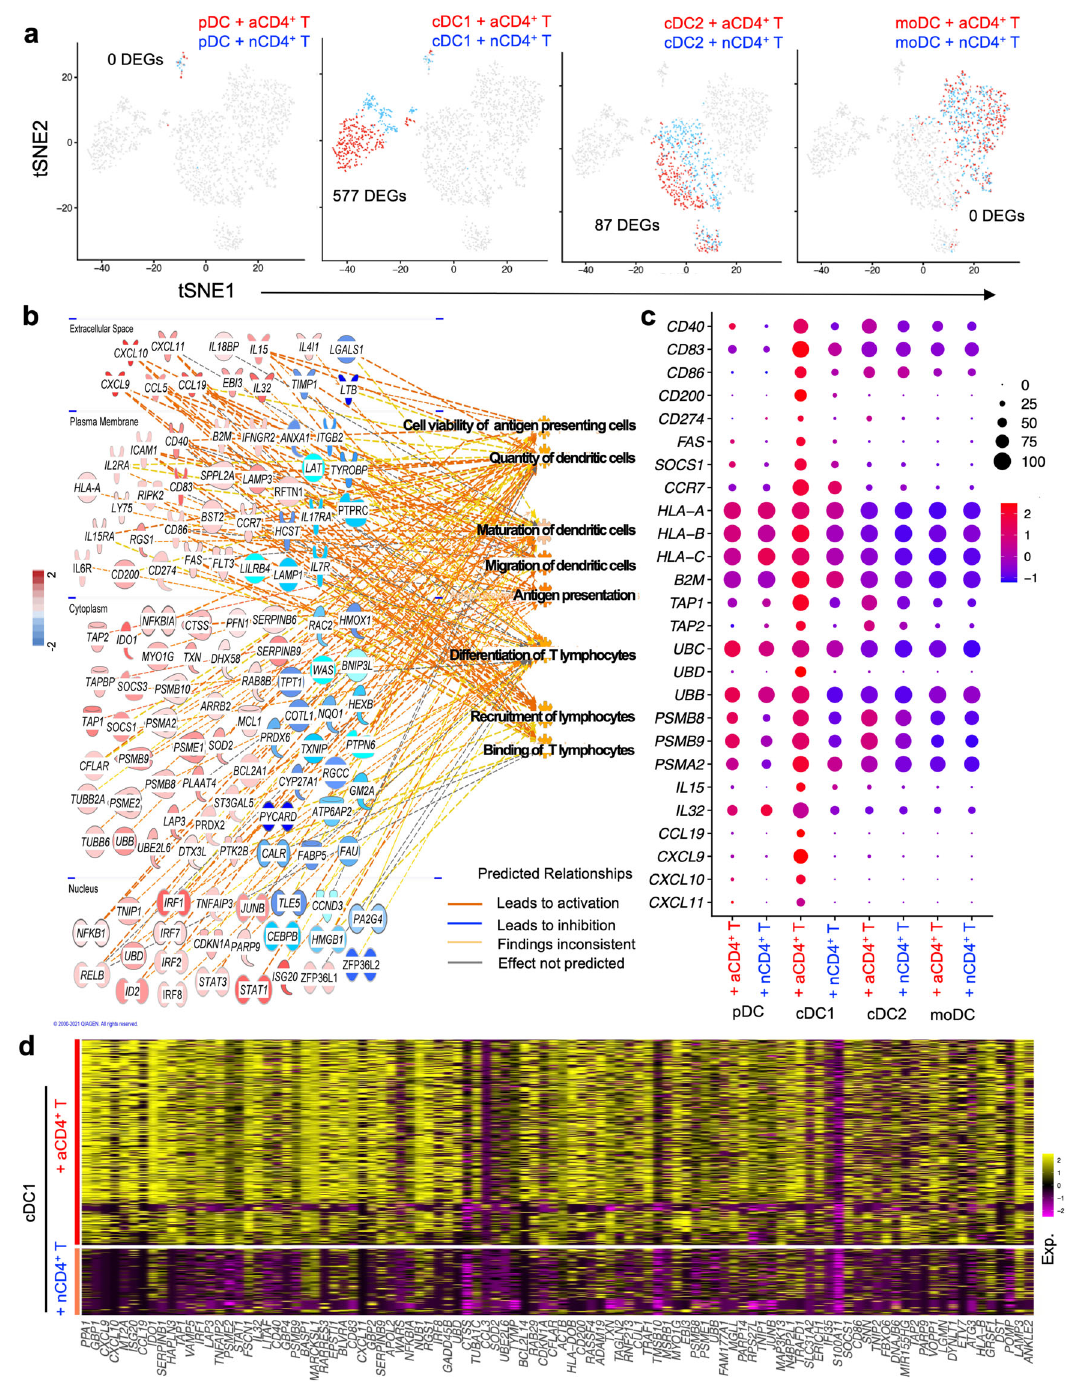
Fig. 1 | “ Helped ” cDC1 increase expressionofmolecular pathways thatsupport CTL cross-priming. CD11c − CD303 + pDC, CD11c + CD141 + cDC1, CD11c + CD1c + cDC2 andCD11c + CD14 + CD206 + moDCwere fl owcytometricallysortedfromhumanPBMC asoutlinedinSupplementaryFig.1a.Cellswereco-culturedwithactivated-ornaive CD4 + T-cells overnight, then stained with antibody to β 2m- conjugated to hashtag oligonucleotides (HTO) 1-8 and oligo-tagged antibody to CD3. After extensive washing steps, HTO 1-8 tagged samples were pooled in equal proportion and loa- ded on a 10X Genomics platform. a tSNE plots highlighting the mRNA expression pro fi